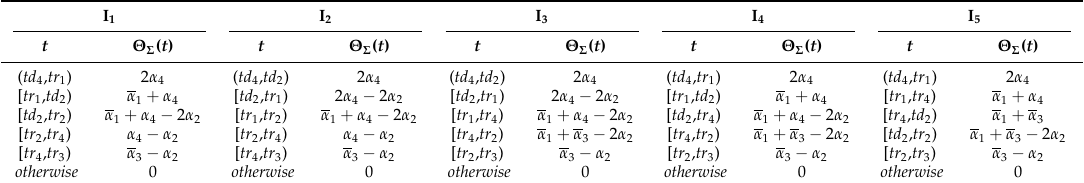
Table 2. Central angle summation of the intersected arc for projection points located in sub-regions I 1 , I 2 , I 3 , I 4 , and I 5